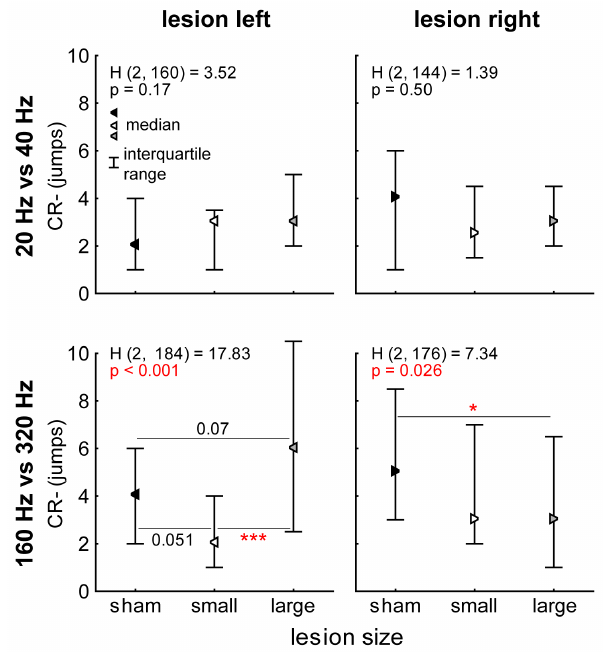
Figure 5. Effects of lesion size on CR-. Given are the median values of wrong jumps over the hurdle (false responses) from day 8 to 15 (stable DP phase) for sham control animals and animals with small and large lesions of the left and right AC during slow (upper panels) and fast AM discrimination learning (lower panels). Whiskers indicate the interquartile range. Between-group comparisons of lesion size effects were performed using Kruskal-Wallis ANOVA and post-hoc multiple comparisons of mean ranks were used to investigate differences between two groups; p-levels: *p , 0.05, ***p , 0.001.